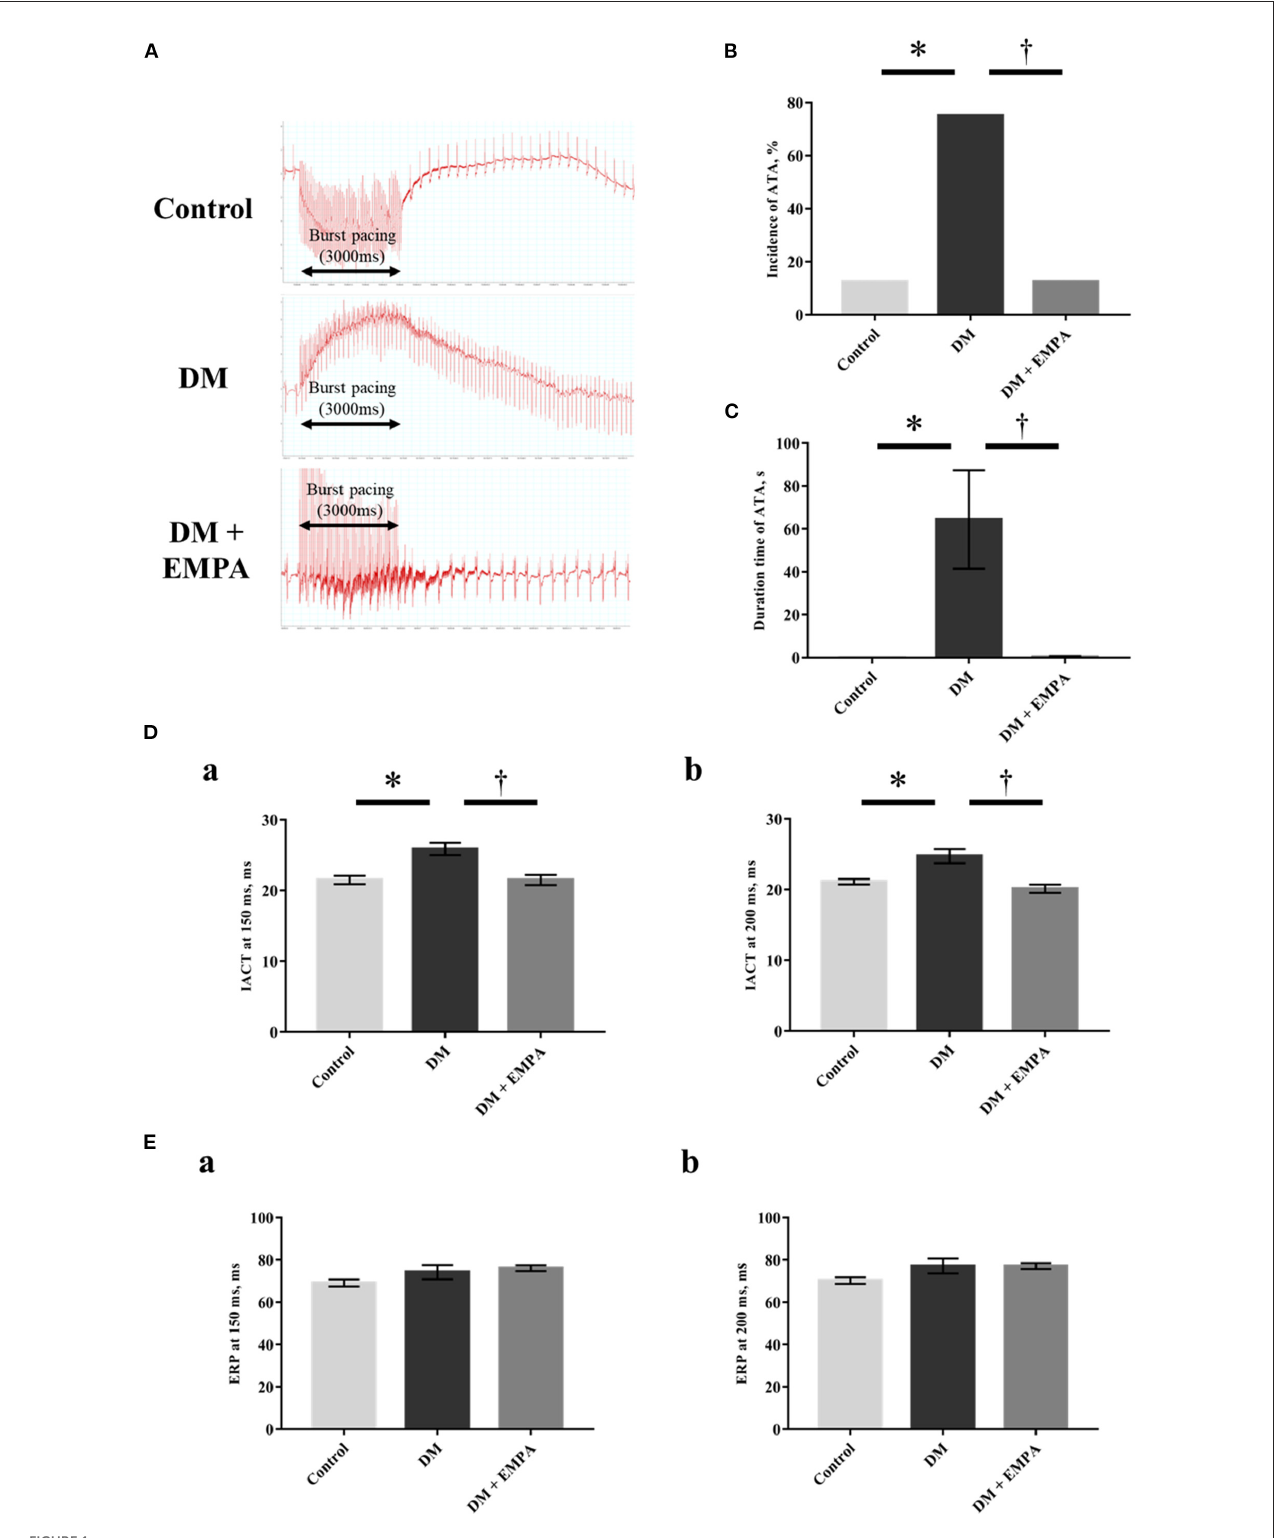
FIGURE1 Electrophysiological study. (A) Representative electrogram traces obtained from rats in the three groups. (B) Incidence of atrial tachyarrhythmia (ATA). (C) Duration time of ATA. (D) Interatrial conduction time (IACT) at pacing cycle length of 150ms (a) and 200ms (b). (E) Effective refractory period (ERP) at pacing cycle length of 150ms (a) and 200ms (b). Data are expressed as mean ± SE ( n = 8 per group). * p < 0.05: vs. Control, † p < 0.05: vs. DM (One-way repeated ANOVA with post hoc Tukey’s multiple-comparison test and Fisher’s exact test). DM, diabetes; EMPA,